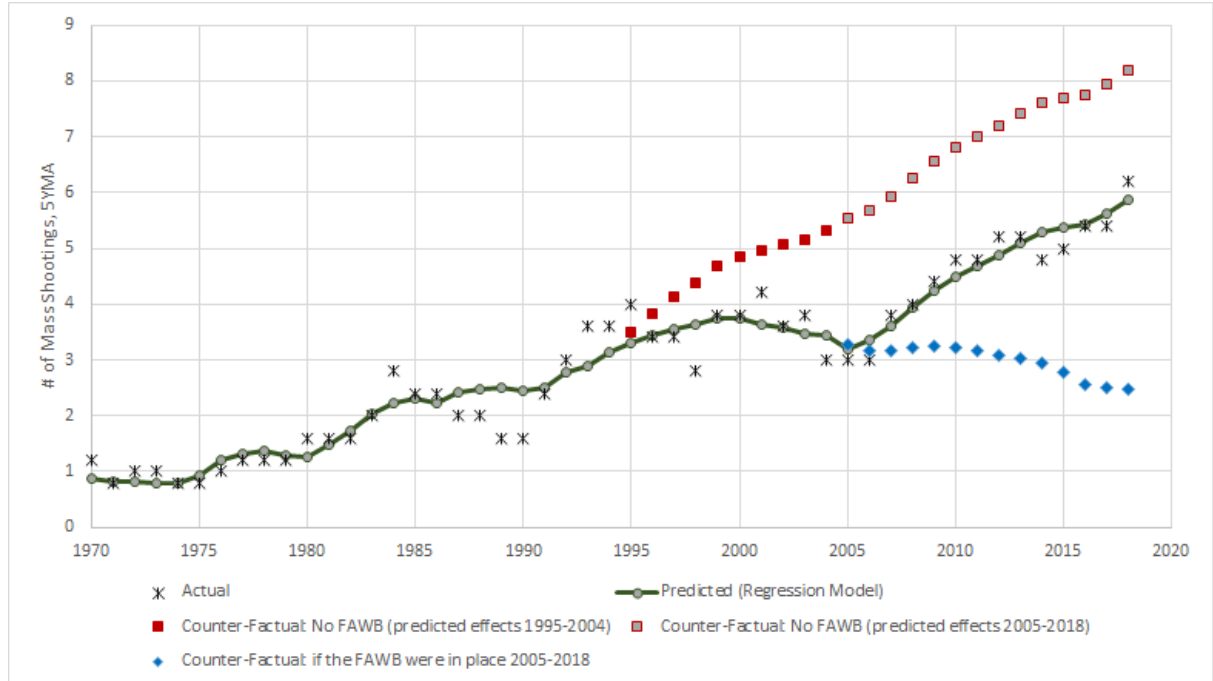
Figure 2. Regression lines from discontinuity analysis of the federal assault weapons ban